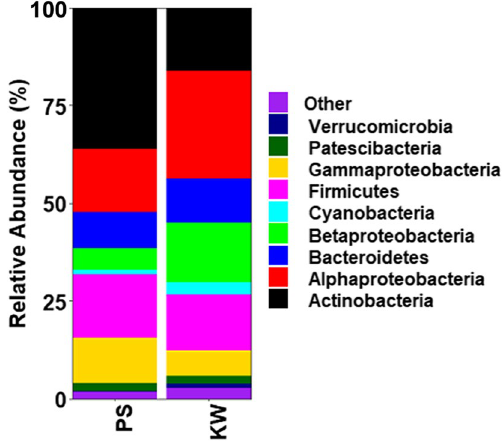
Figure 1. Relative abundances of bacterial phyla associated with permethrin-selected (PS) and parent strain (KW) of Aedes aegypti